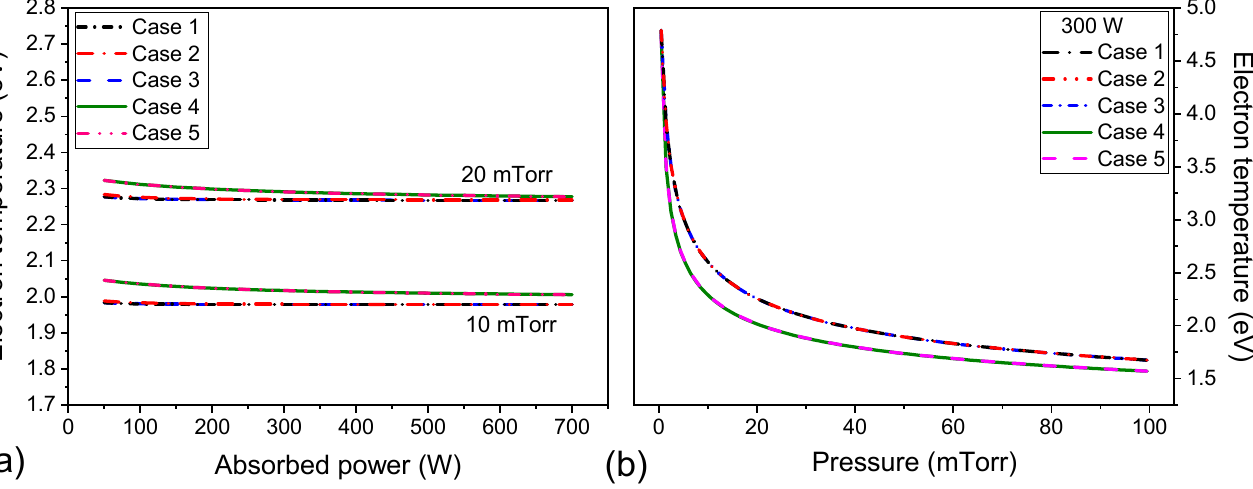
Figure 4. Electron temperature as a function of absorbed power at 10 mTorr and 20 mTorr ( a ) and gas pressure at 300 W ( b ) for the five cases